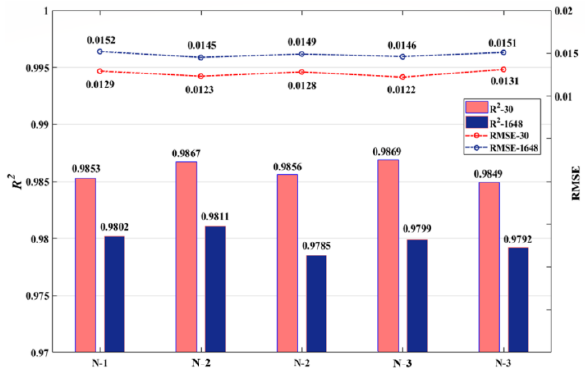
Figure 7. Tests for variation of topology.